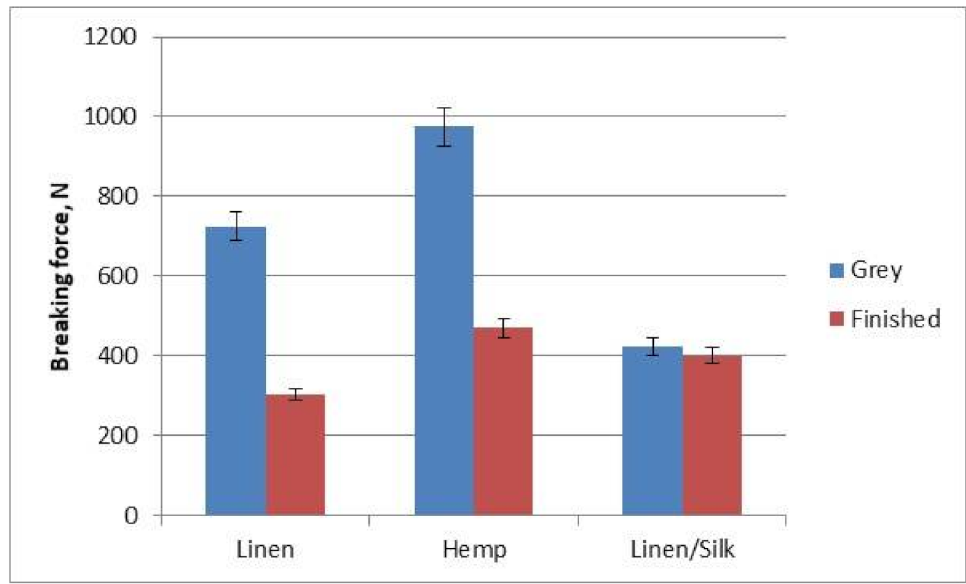
Figure 9. Diagram of the fabrics’ breaking force.